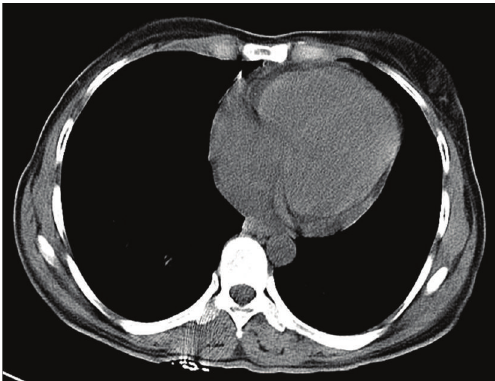
Figure 1: Ultrasonography of abdomen showed a minimal pericar- dial e ff usion. Figure 2: Computed Tomography scan (CT scan) of abdomen showed a minimal pericardial e ff